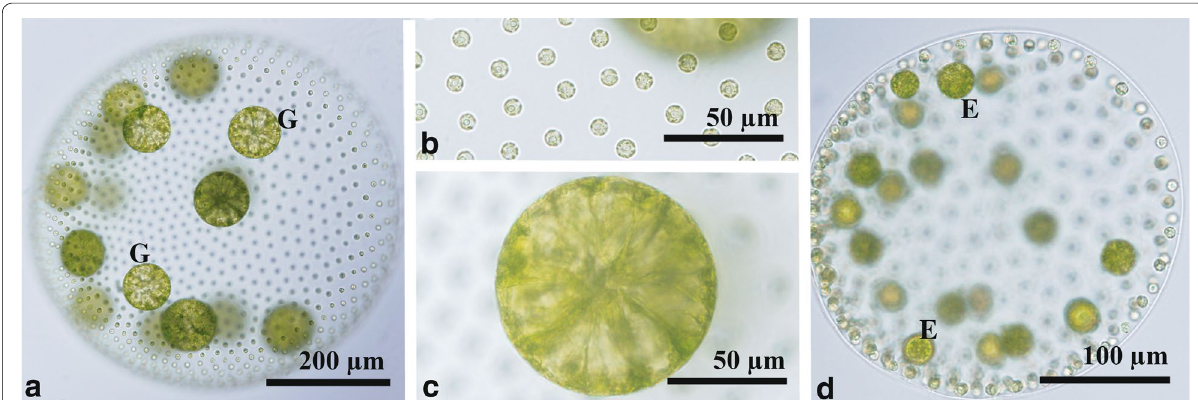
Fig. 5 Light microscopy of a putative female strain (2016‑tw‑nuk‑8‑2) with no amplification of HMG1f in genomic PCR (see Fig. 3 and Additional file 1: Figure S2). a Asexual spheroid with 16 gonidia (G). b Surface view of asexual spheroid showing no cytoplasmic bridges between cells. c Opti‑ cal section of gonidium in asexual spheroid. d Female spheroid with eggs